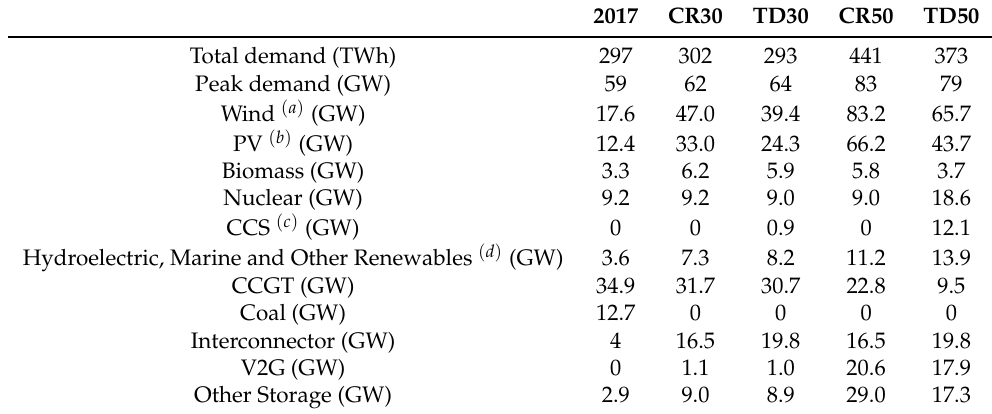
Table 2. Demand characteristics and generator capacities in 2017 and the Community Renewables (CR) and Two Degrees (TD) scenarios of FES 2018, in 2030 (CR30, TD30) and 2050 (CR50, TD50)